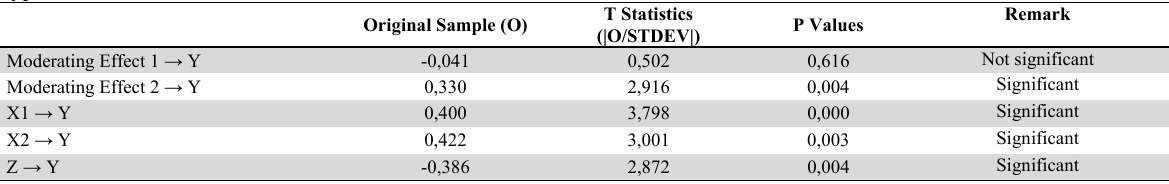
Fig.1 indicates that the model consists of 2 independent variables, 1 moderator variable with 2 effect moderators and 1 de- pendent variable. The hypothesis test results can be seen in Table 3.